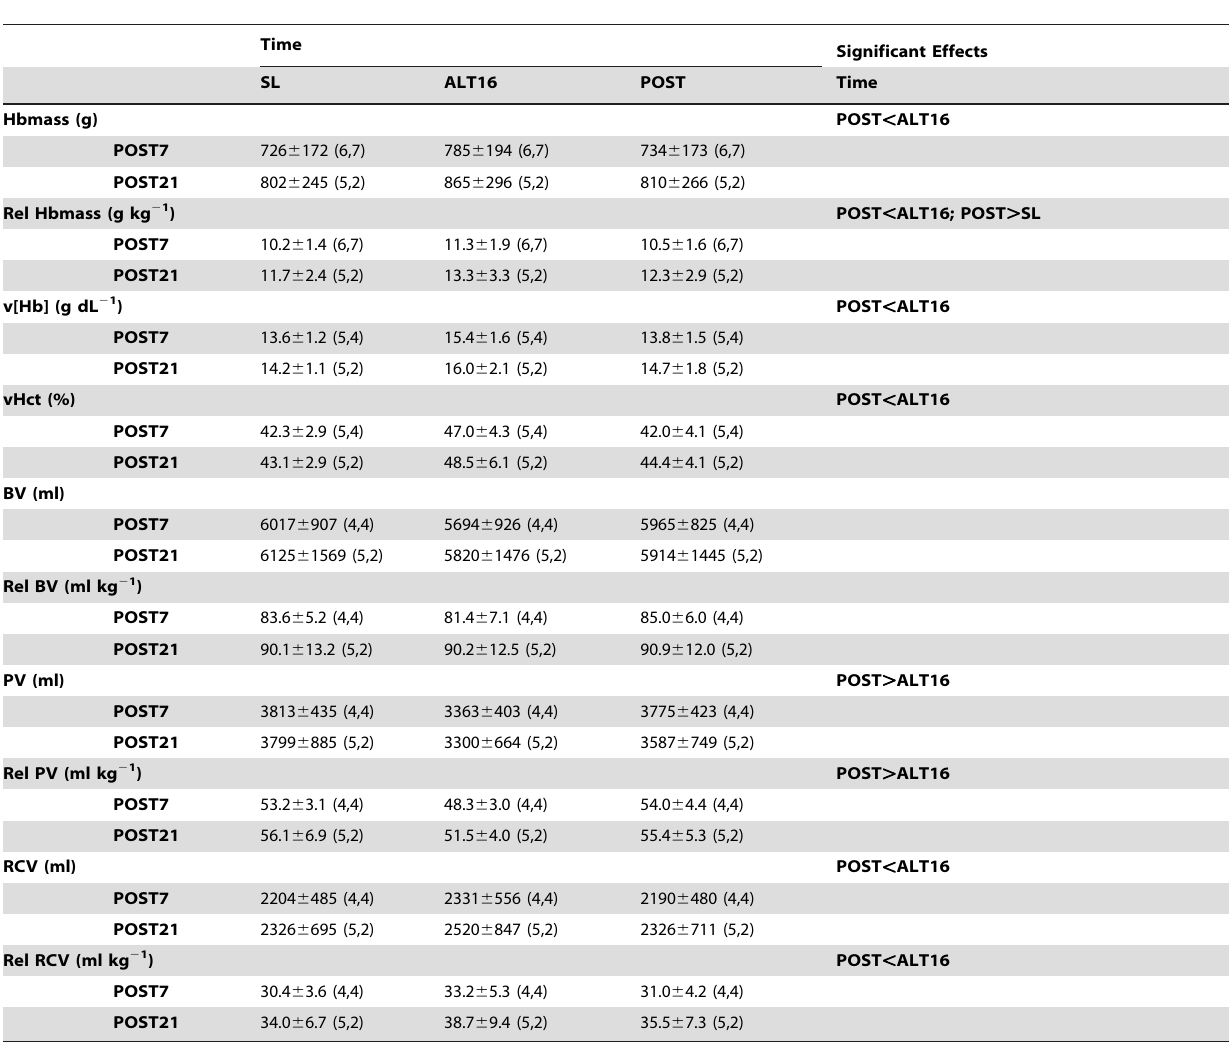
Table 4. Hematological adaptations following descent from high altitude to low altitude.